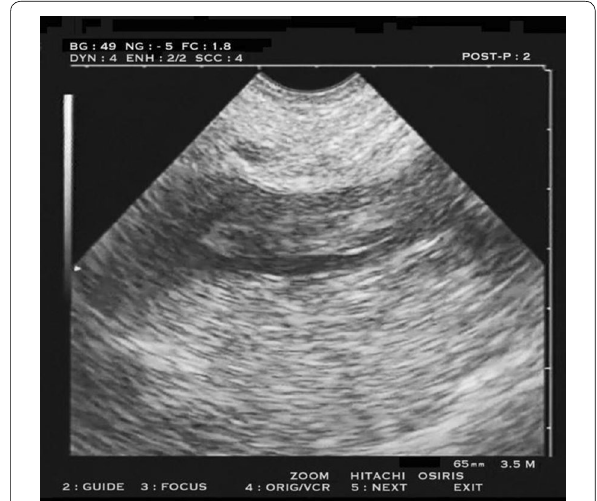
Fig. 1 Deep venous thrombosis at the external iliac vein (long axis), perfectly visible using a microconvex probe. The pattern of floating thrombosis, typical here, is even more obvious on video. The volume is substantial enough for likely generating serious hemodynamic troubles in case of dislodgement, so this pattern should make reconsider the safety of the